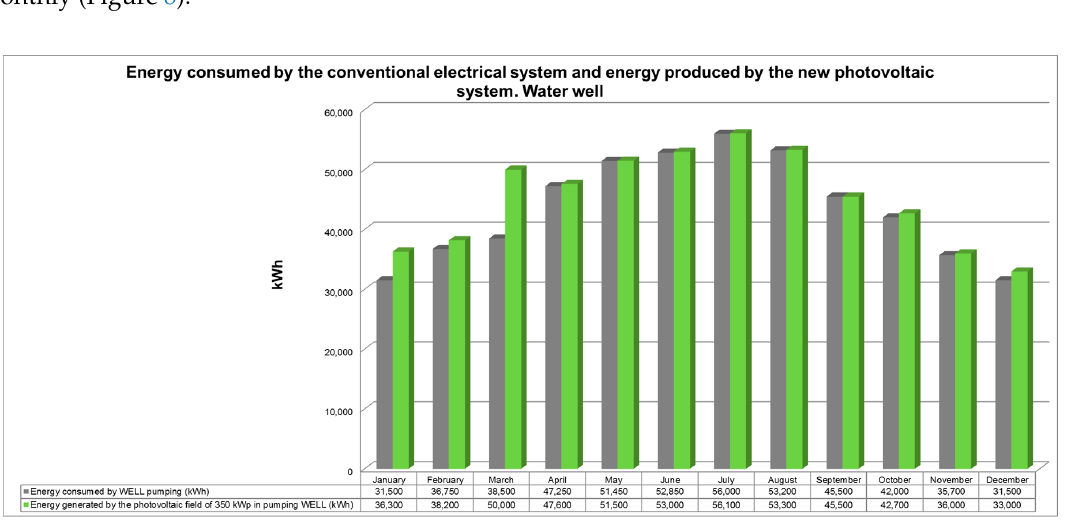
Figure 8. Energy consumed by the conventional electrical system and energy produced by the new photovoltaic system (water well).